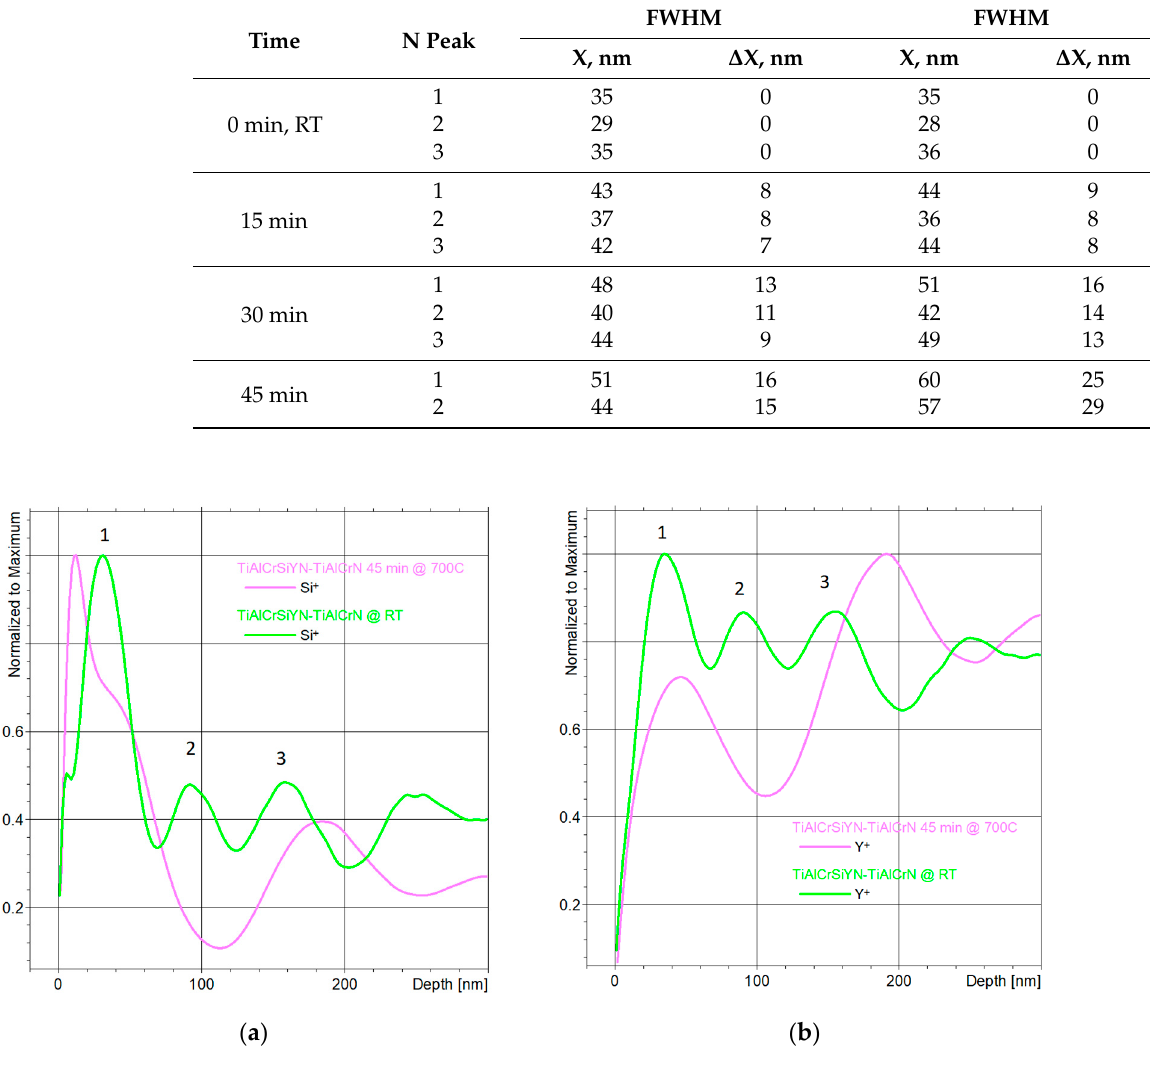
Figure 5. Depth distribution of silicon ( a ) and ( b ) yttrium on the surface of a Ti 0.2 Al 0.55 Cr 0.2 Si 0.03 Y 0.02 N/Ti 0.25 Al 0.65 Cr 0.1 N coating before and after annealing at 700 °C for 45 min.